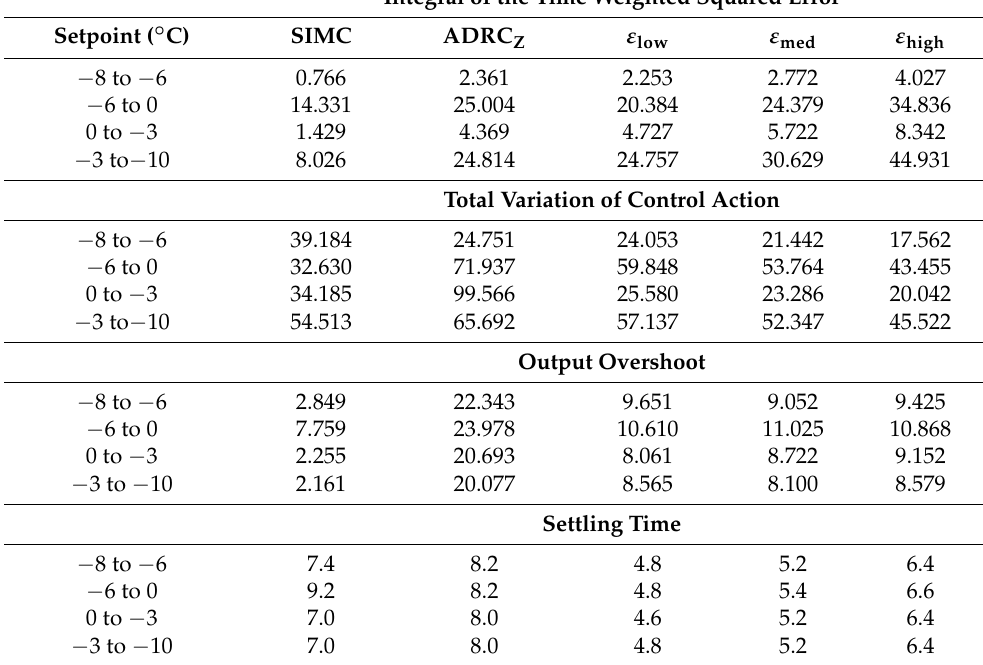
Table 11. Performance comparison of proposed tuning rules and reference controllers for the setpoint response of the Peltier